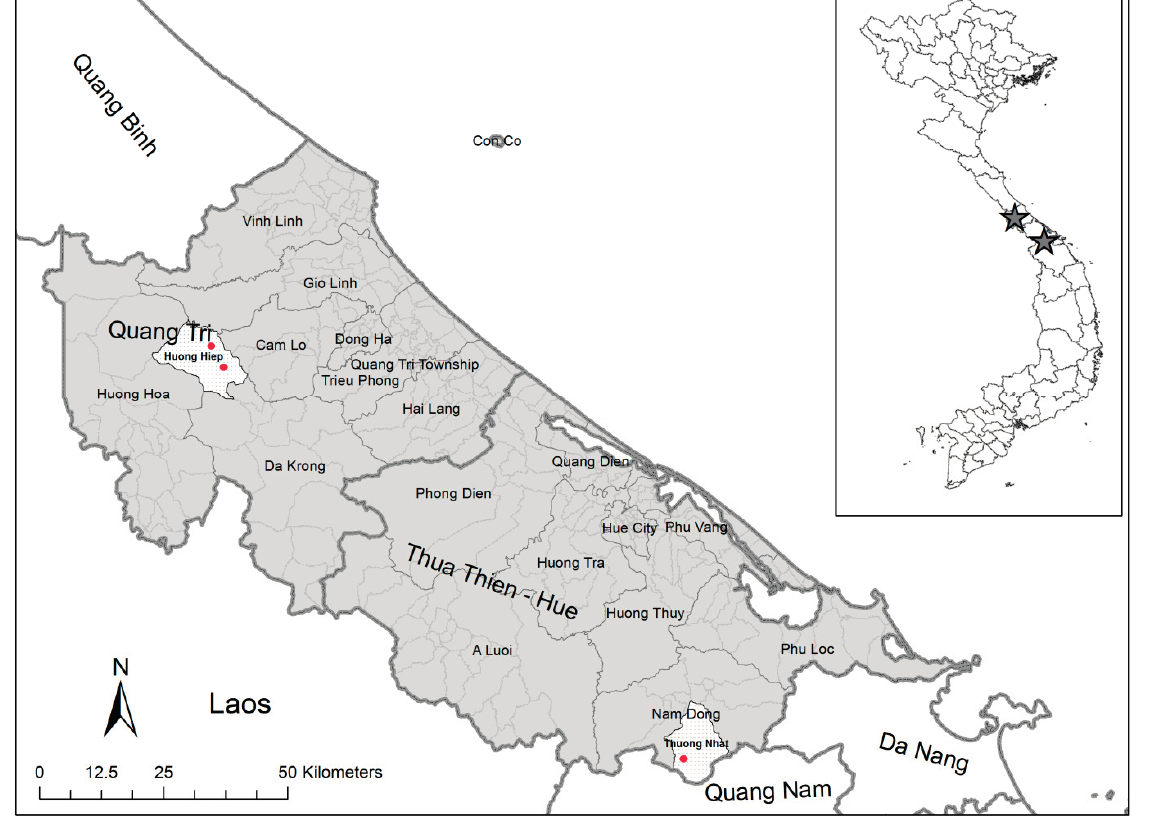
Note: Red dots are indications of the location of the